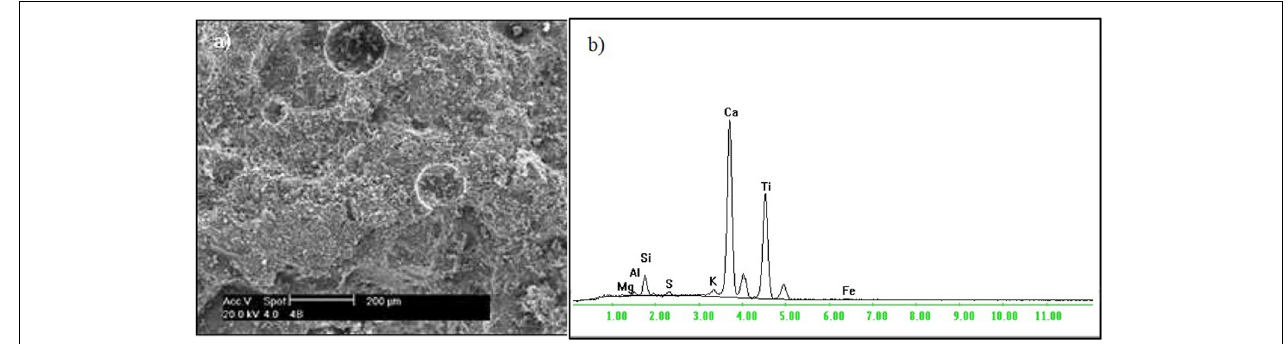
FIGURE 4 | SEM images (a) and EDAX (b) performed on HL-S TiO 2 mortar.